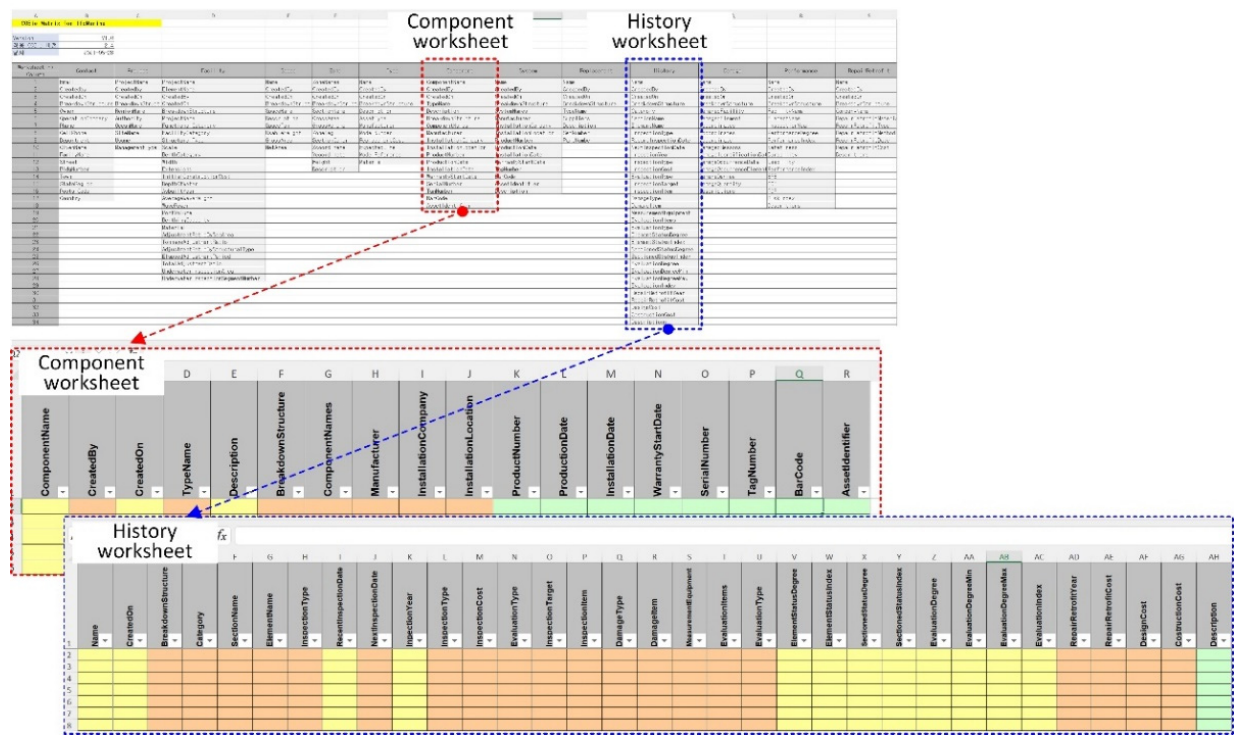
Figure 8. Configuration of port BIM-based COBie schema.